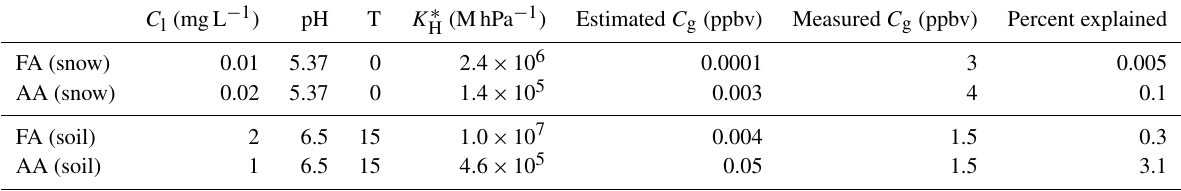
Table 4. Estimated equilibrium mixing ratios for literature values of formate and acetate in snow and soil. Measured values for comparison are higher for the snow case as mixing ratios were higher earlier in the campaign. pH values for snow are for melted fresh snow at Alert (Macdonald et al., 2017). pH values for soil were measured from soil cores in the vicinity of Alert (Sect. 2.5). C l (mgL − 1